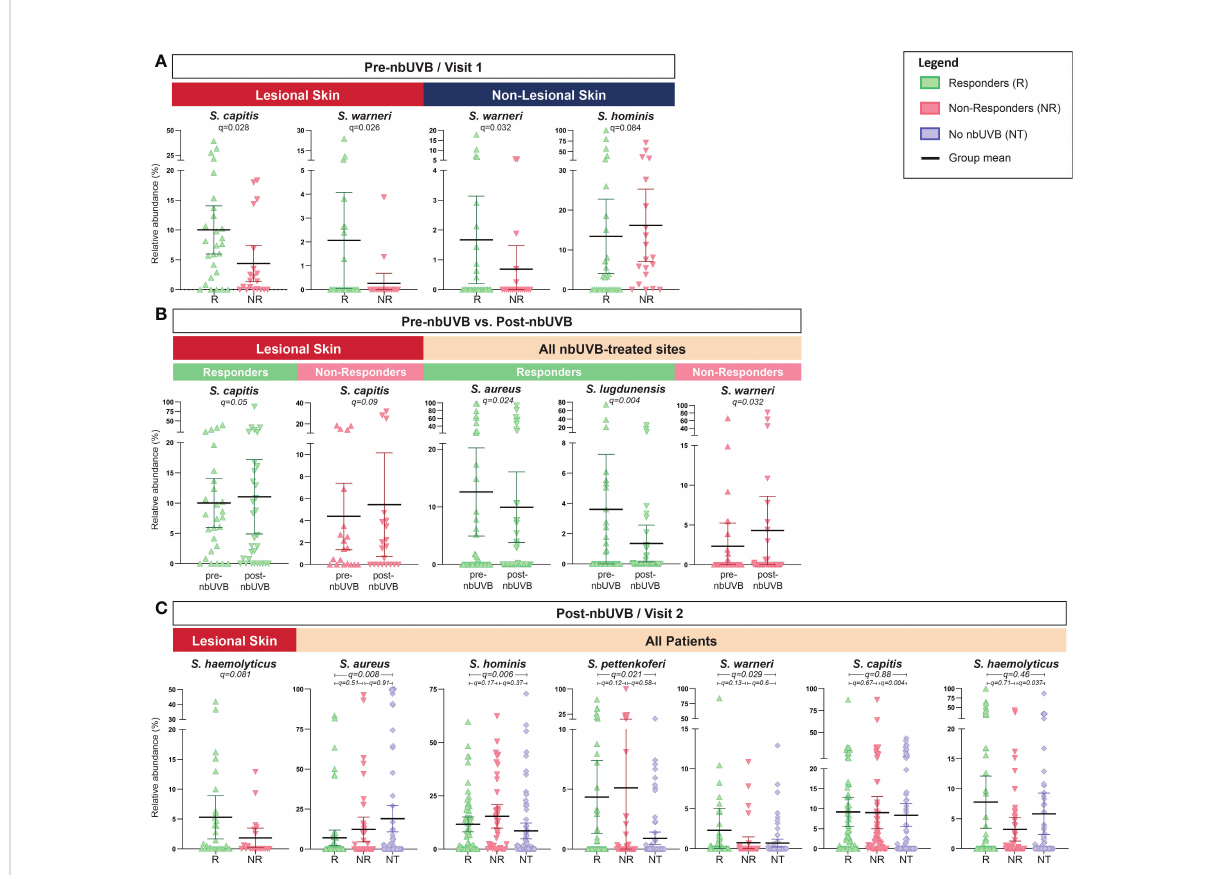
FIGURE 5 Staphylococcus species abundance differentiates nbUVB responders, nbUVB non-responders, and no-nbUVB patients. Differential analysis demonstrated signi fi cant shifts in various staphylococcal species including S. aureus , S. lugdunensis , S. hominis , and S. haemolyticus characterize R, NR, and no-nbUVB (not treated; NT) skin (A) pre-nbUVB, (B) pre- versus post-nbUVB, and (C) post-nbUVB. Black horizontal bars indicate group means with 95% con fi dence